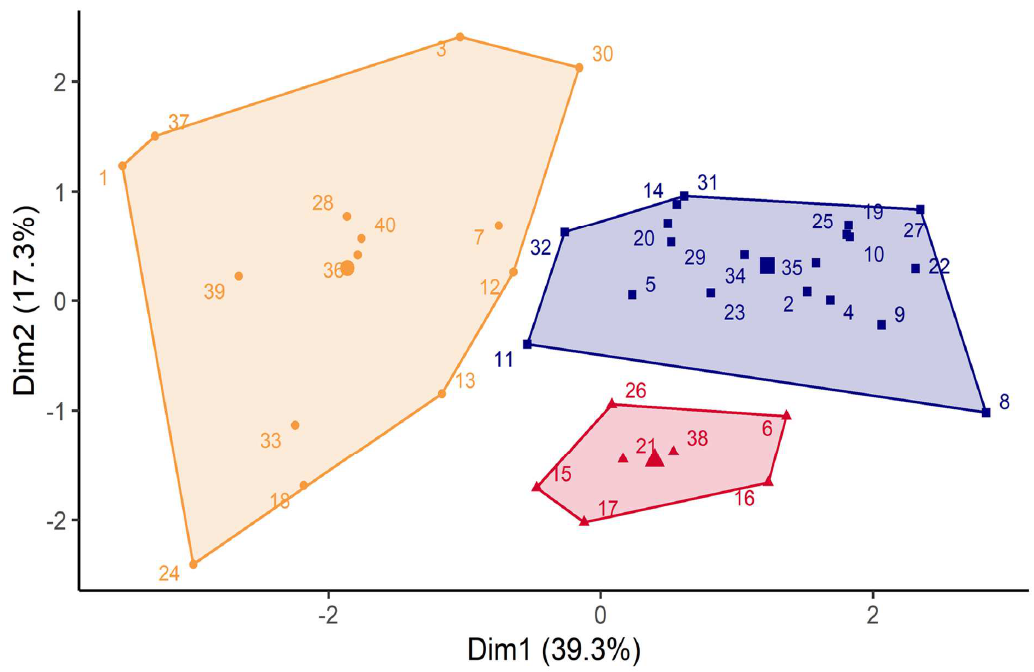
Figure 2. Factor map obtained by agglomerative hierarchical cluster analysis. Cluster 1 (orange) included 7 males and 7 females with the highest age and BMI and the lowest physical fitness and physical activity level. They were characterized by an effort limitation (%VO 2predicted < 77%); Cluster 2 (blue, 12 males and 7 females) and Cluster 3 (red, 5 males and 2 females) were characterized by normal BMI and very good VO 2peak values. Participants in Cluster 2 had the highest static and dynamic balance score. Participants in Cluster 3 had the highest flexibility, explosive and isometric strength.